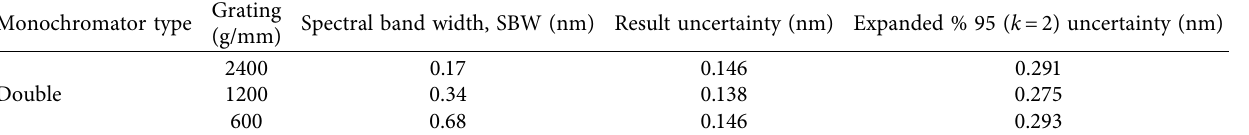
Table 1: Results showing the measurement uncertainty for double monochromator